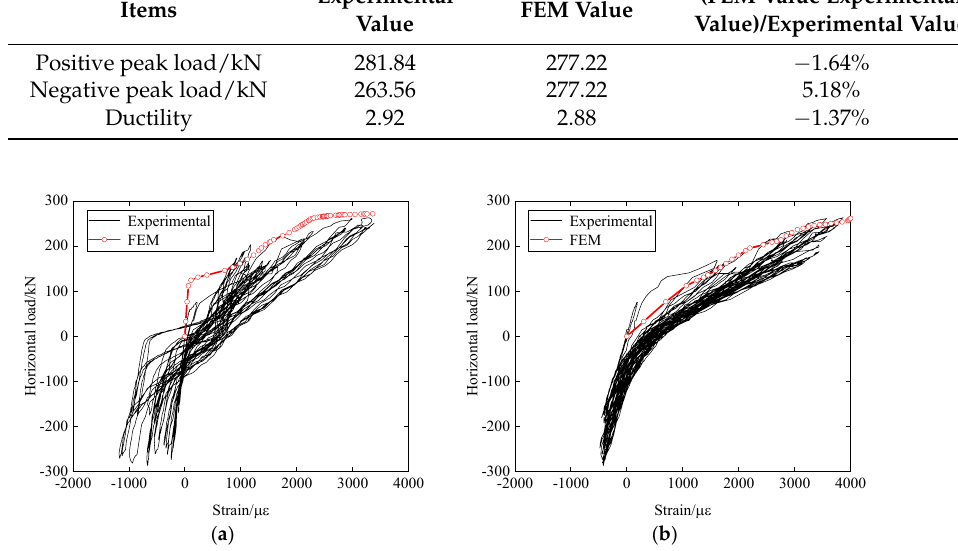
Figure 9. Comparison of load ‐ strain curves for reinforcement between FEM and experimental results. ( a ) Outer reinforcement at the upper end of sidewall; ( b ) Outer Reinforcement at the lower end of sidewall.